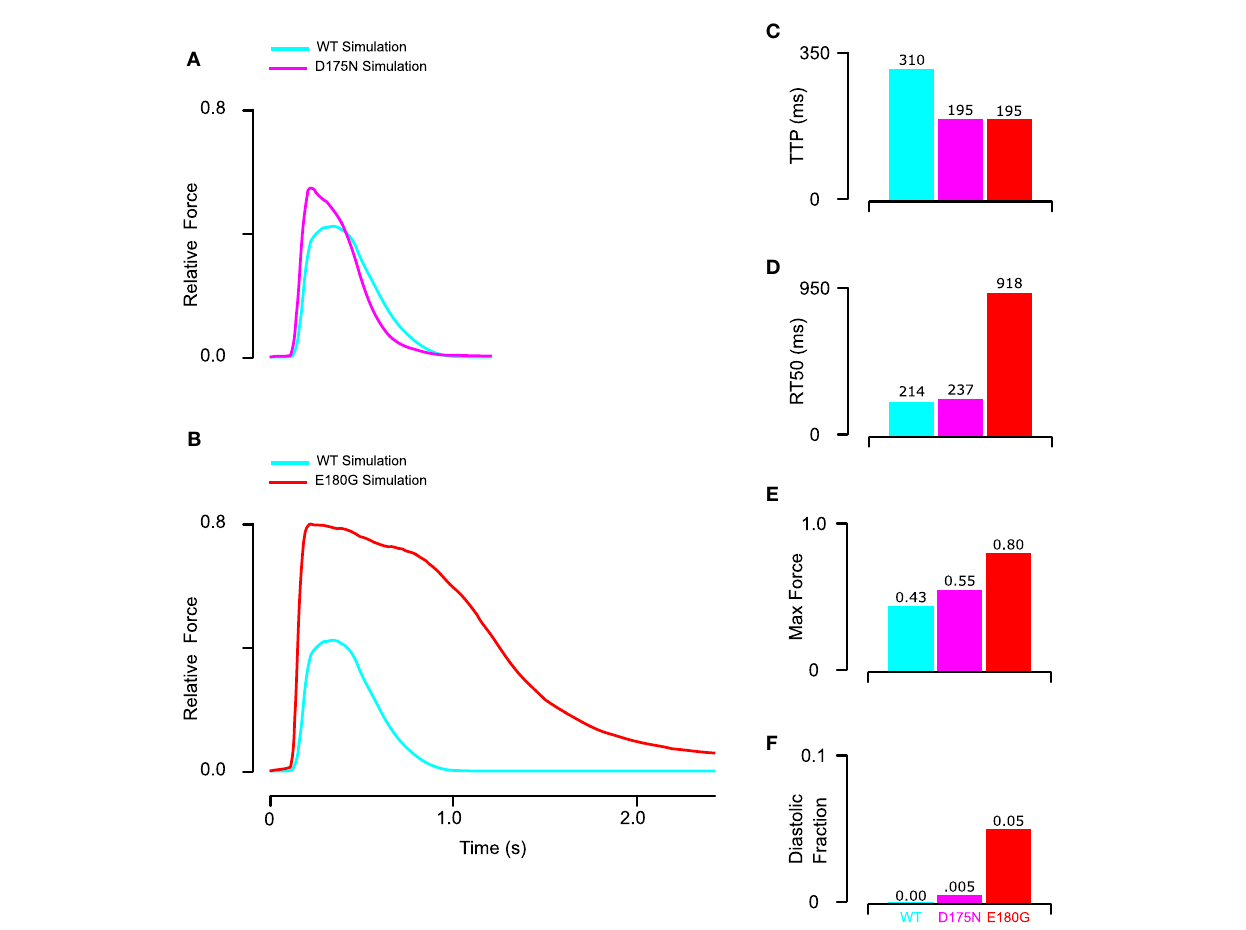
FIGURE 6 | Prediction of mutant twitch based on properties altered by mutant tropomyosin from fitting of the reconstituted myocardium data. (A) D175N mutant twitch was predicted by applying a 40% increase in stiffness and a 15% decrease in BC equilibrium constant. (B) E180G mutant twitch was predicted by applying a 15% increase in duty cycle, 10% increase in BC equilibrium, and 25% reduction in stiffness. (C) Both E180G and D175N mutants reduced the time to peak to the minimum value possible in the model for the given measured calcium transient. (D) E180G and D175N increased the time from peak tension to 50% relaxation though D175N was predicted to be far more modest than E180G. (E,F) Both E180G and D175N mutants were predicted to increase maximum and diastolic force production though E180G had a larger